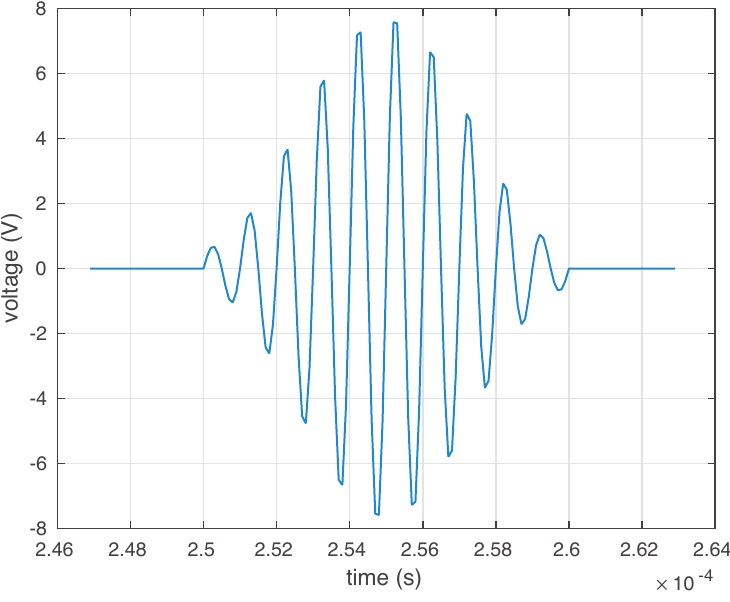
Figure 3. Aluminum plate instrumented with four piezoelectric sensors ( S 1, S 2, S 3, and S 4).